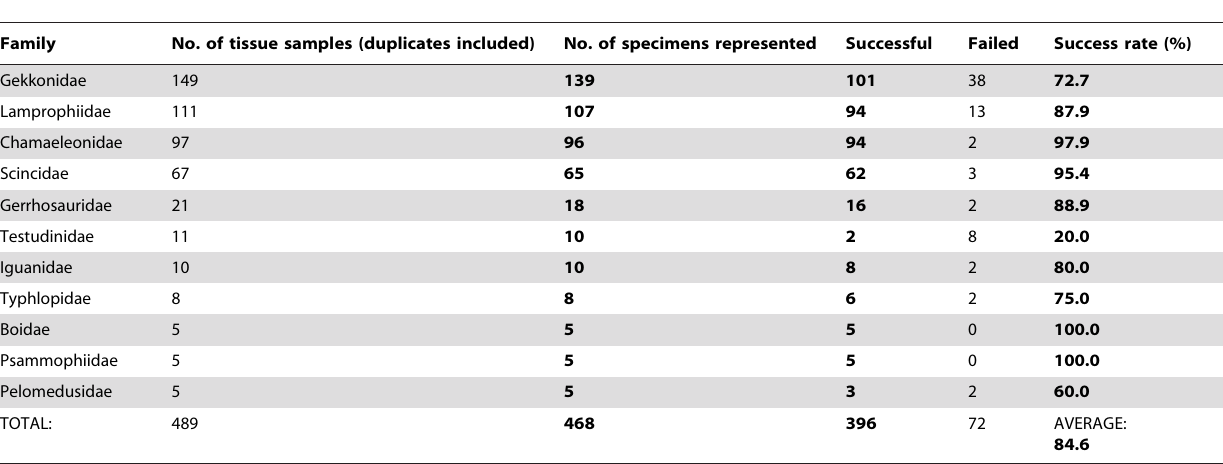
Table 1. Success rates of DNA sequencing according to the taxonomy.